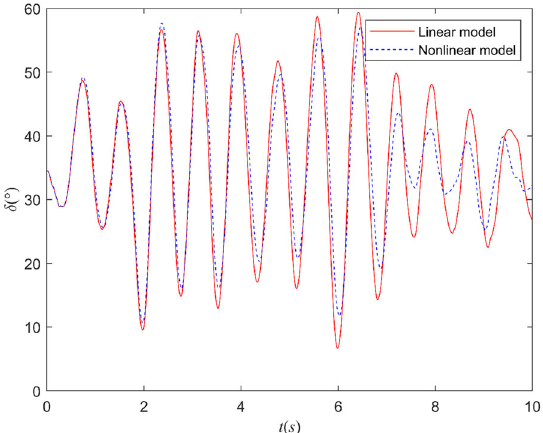
Fig. 9 Comparison of power angle curves between linear and nonlinear models of the system ( σ =